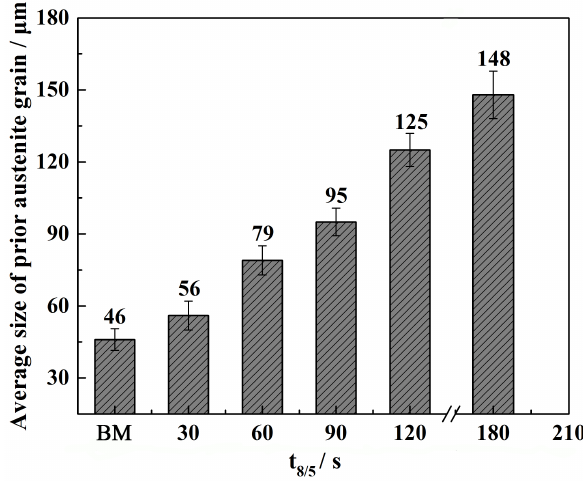
Figure 5: Prior austenite grain size of the BM and the simulated CGHAZ versus t 8/5 (The error bars represent standard